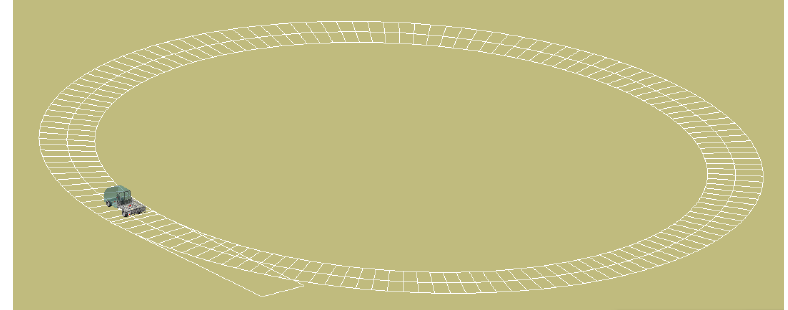
Figure 15. The simulation diagram of the braking-in-turn test based on Adams.